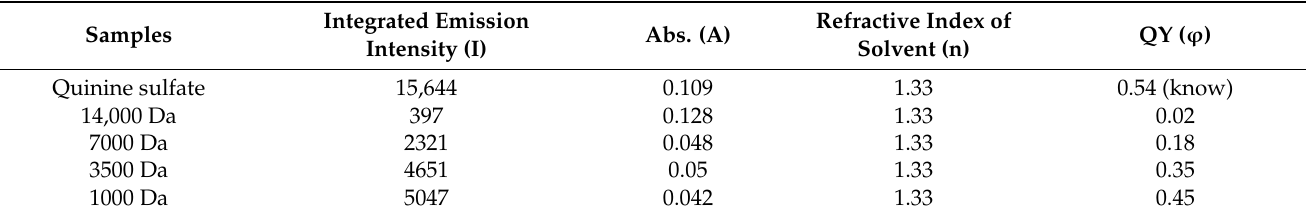
Table 2. QY of the four separated GQDs under excitation at 330 nm using quinine sulfate as a reference. Samples